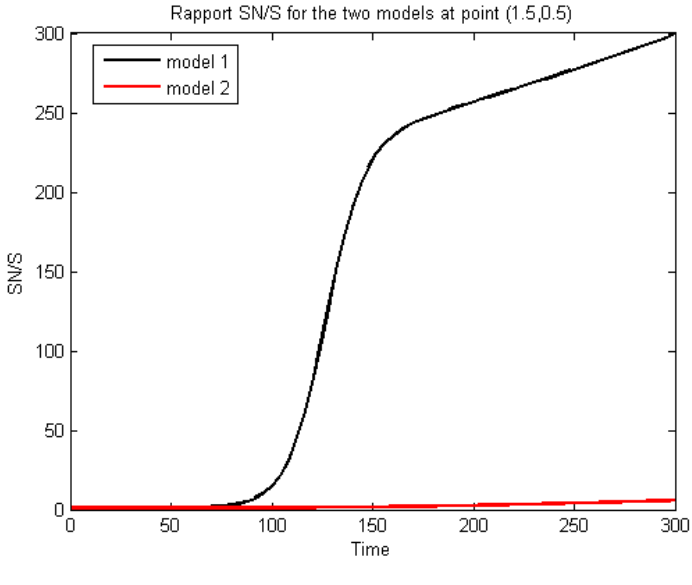
Figure 7. S N with respect to S .